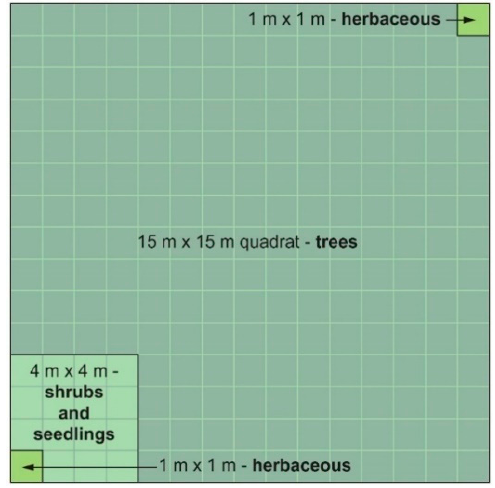
Figure 2. Schematic of the quadrat placement within each experimental unit. Each disturbance category was sampled with 6 to 10 experimental units; undisturbed forest contained 30 units. Table 2. Cumulative accounting of species of trees and shrubs observed within 11 disturbance categories in the Miller Creek Demonstration Forest in northwestern Montana, USA. Nitrogen-fixing species are shown in